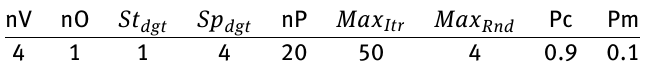
Table 15: VSSCGA Settings for Rosenbrock’s function with 2